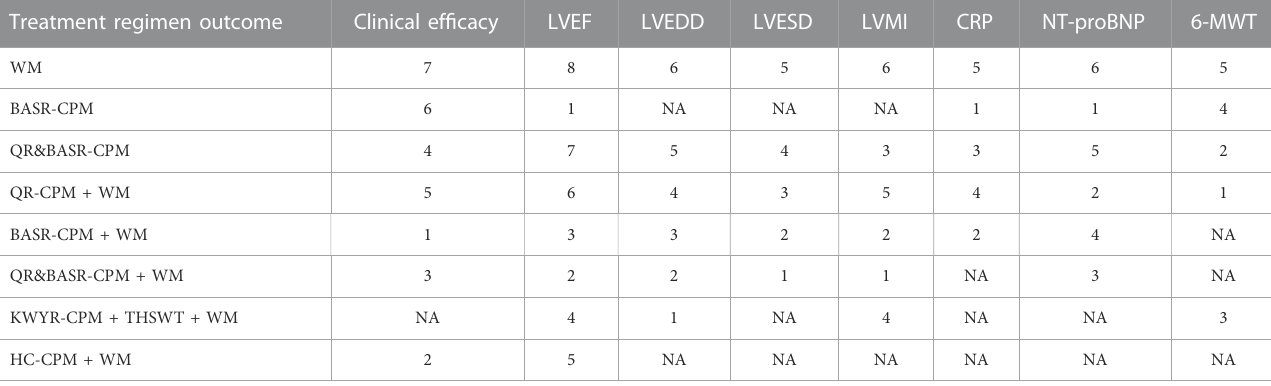
TABLE 12 All treatment regimen information on each outcome. Treatment regimen